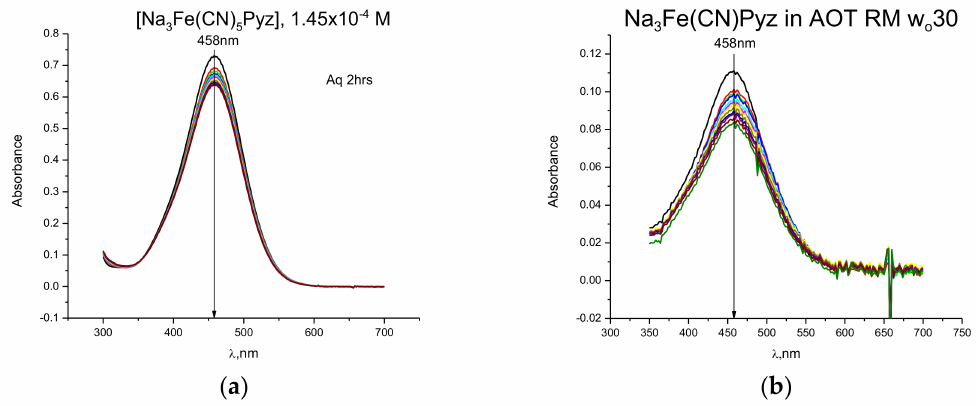
Figure 1. Hydrolysis of aqueous ( a ) and confined solutions ( b ) of an iron-pyrazine complex in 200 mM AOT in isooctane. The concentration of Na 3 [Fe(CN) 5 pyz] is 2.45 × 10 − 4 M and approximately m in the AOT/isooctane RM